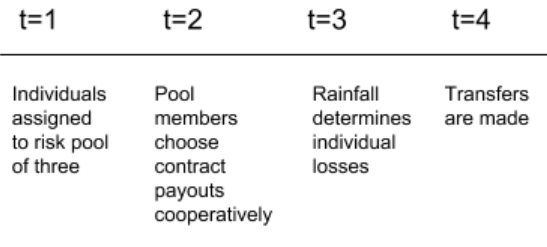
Figure 1. Timeline for Group